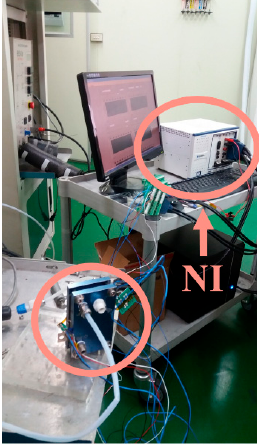
Figure 8. Test and correction of micro hydrogen sensor.